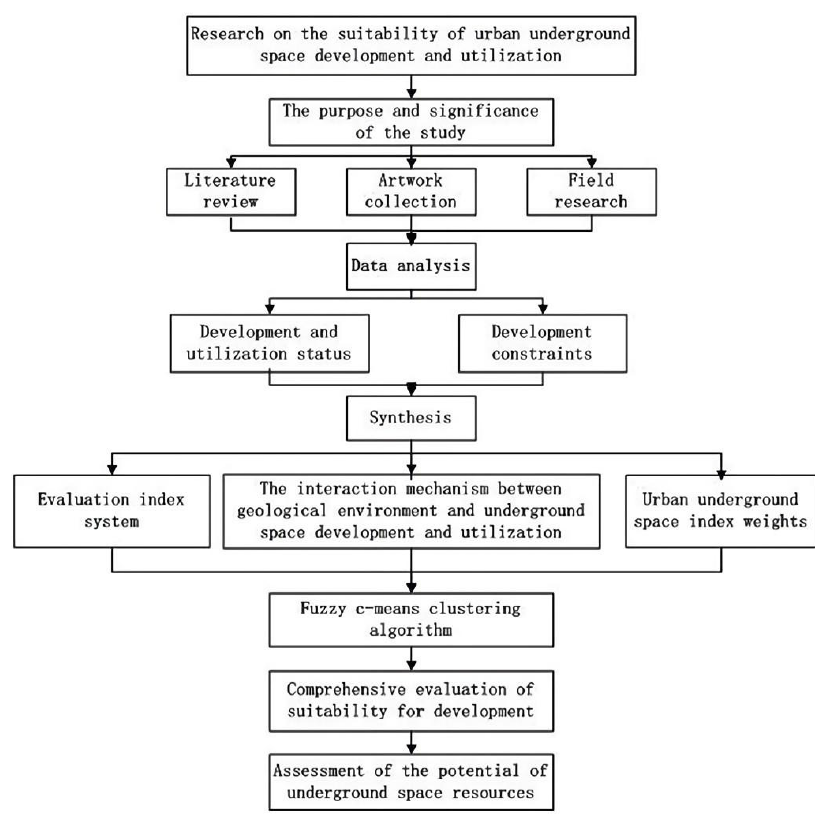
Figure 2. Overall technical route of urban underground space resource assessment.